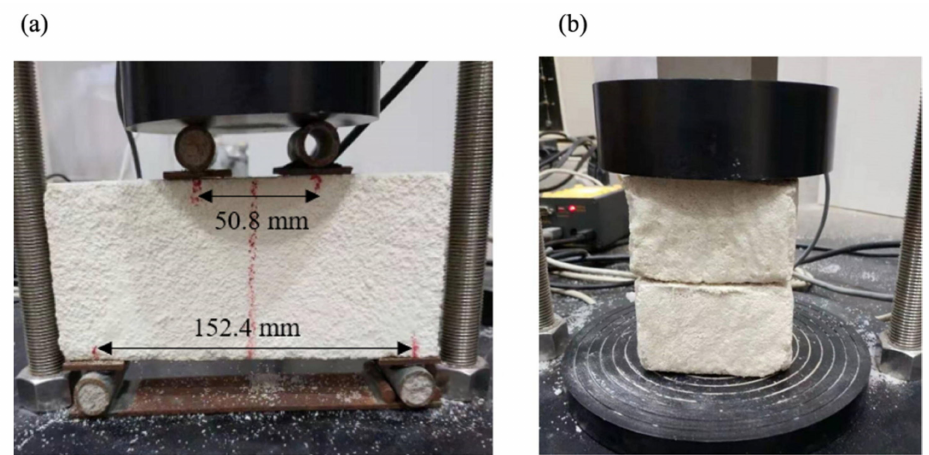
Figure 7. Schematic diagram of MICP test system. ( a ) Four-point bending test system; ( b ) Compres- sive strength testing system